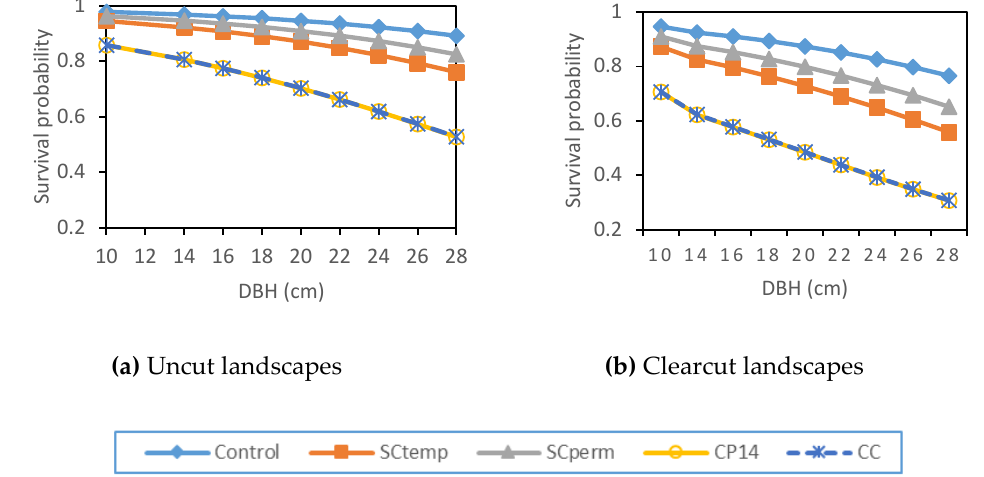
Figure 5. Balsam fir survival probability according to the landscape surrounding the treated area [36]. ( a ) Treated areas within an uncut landscape, ( b ) Treated areas within clearcuts.